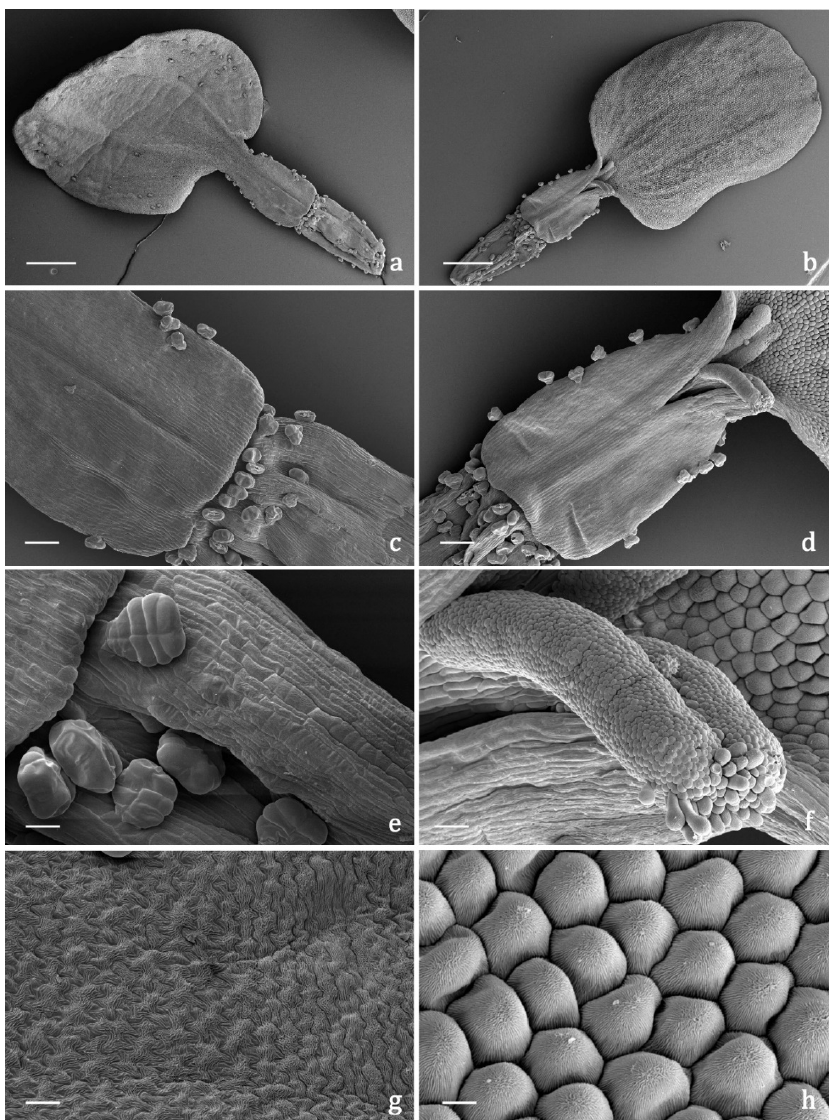
Figure 7. SEM micrographs showing the pistillate ray florets of the capitulum of Achillea moschata . ( a , b ) General view of a ray floret: abaxial ( a ) and adaxial ( b ) sides. ( c , d ) Details of the proximal portion of the corolla tube and of the distal portion of the ovary: abaxial ( c ) and adaxial ( d ) sides. ( e ) Biseriate, 10-celled glandular trichomes on the distal portion of the ovary. ( f ) Details of the 2-lobed stigma with a papillose surface. ( g ) Epidermis of the ligule adaxial side with elongated puzzle-like striated cells. ( h ) Epidermis of the ligule adaxial side with isodiametric conical striated cells. Scale bars: 500 μ m ( a , b ); 100 μ m ( c , d ); 20 μ m ( e , f ); 10 μ m ( g , h ). No previous micromorphological contribution was found on the target species, while the literature data referred to works focused on European and Western Asian congeneric species. Secretory canals and both covering and glandular trichomes were described on both vegetative and reproductive organs by light and electron microscopy [16–21]. The canals were never thoroughly investigated and the literature reported only generic